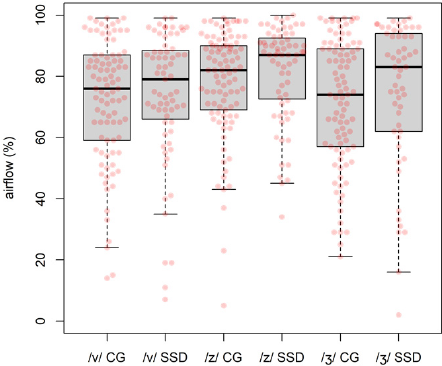
Figure 3. Relative oral airflow data.